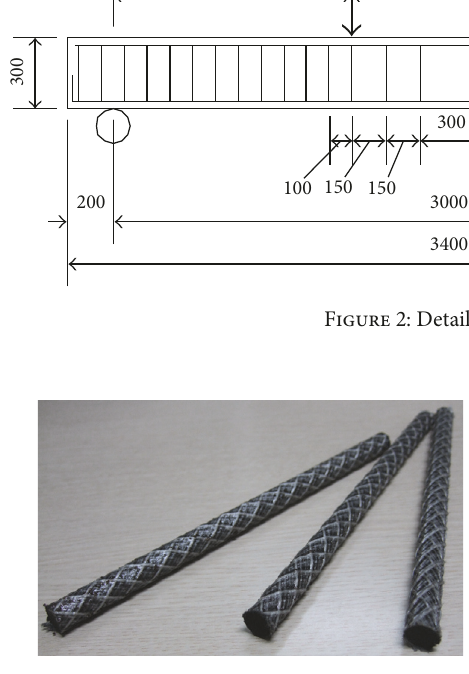
Figure 3: Shape of CFRP